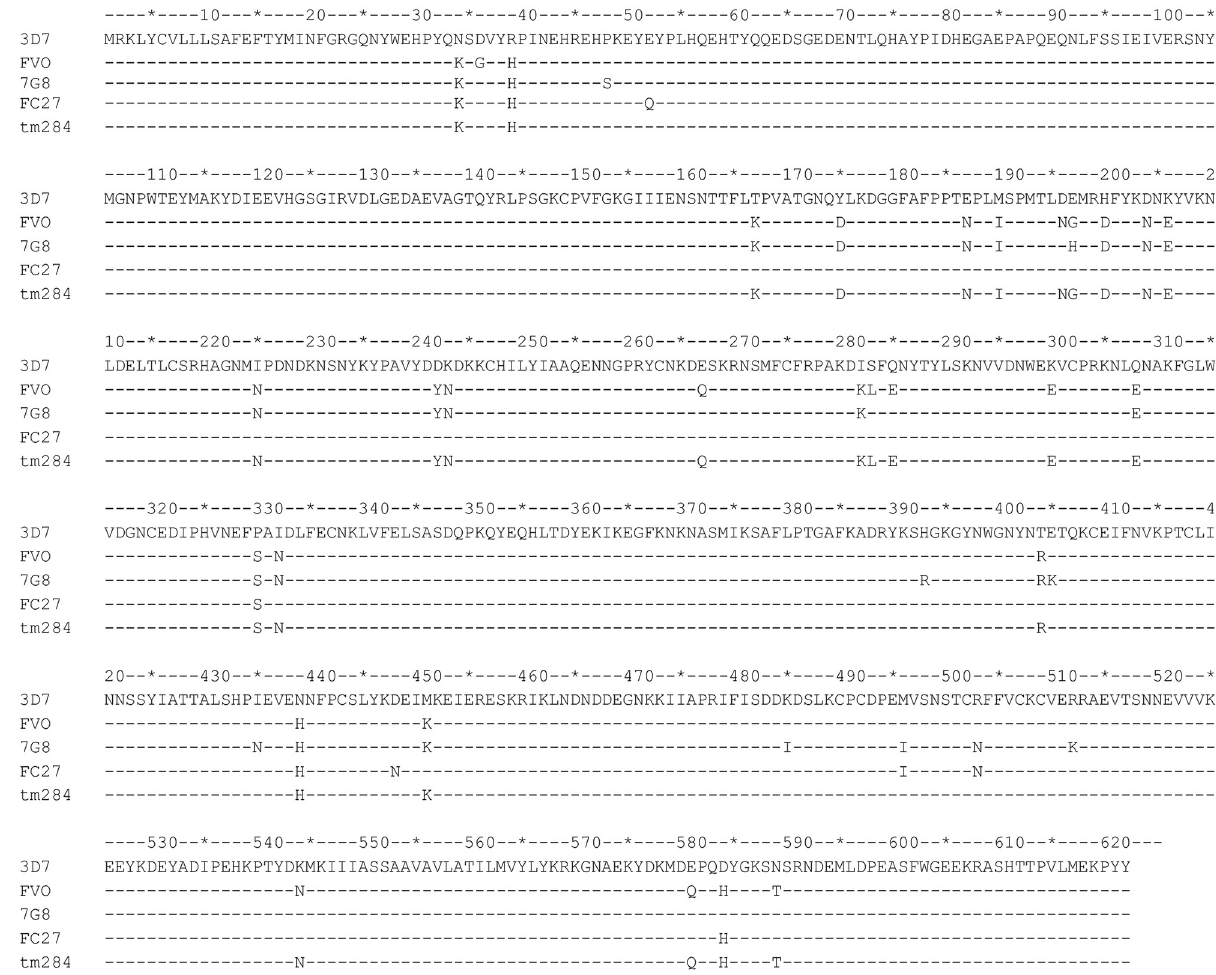
Fig 1. Alignment of P . falciparum AMA1 sequences from the five parasite strains. Sequences for the 3D7, FVO, 7G8, FC27 and tm284 parasite strains were sourced from GenBank and aligned using a Microsoft Excel-based alignment algorithm to identify polymorphic residues across the different